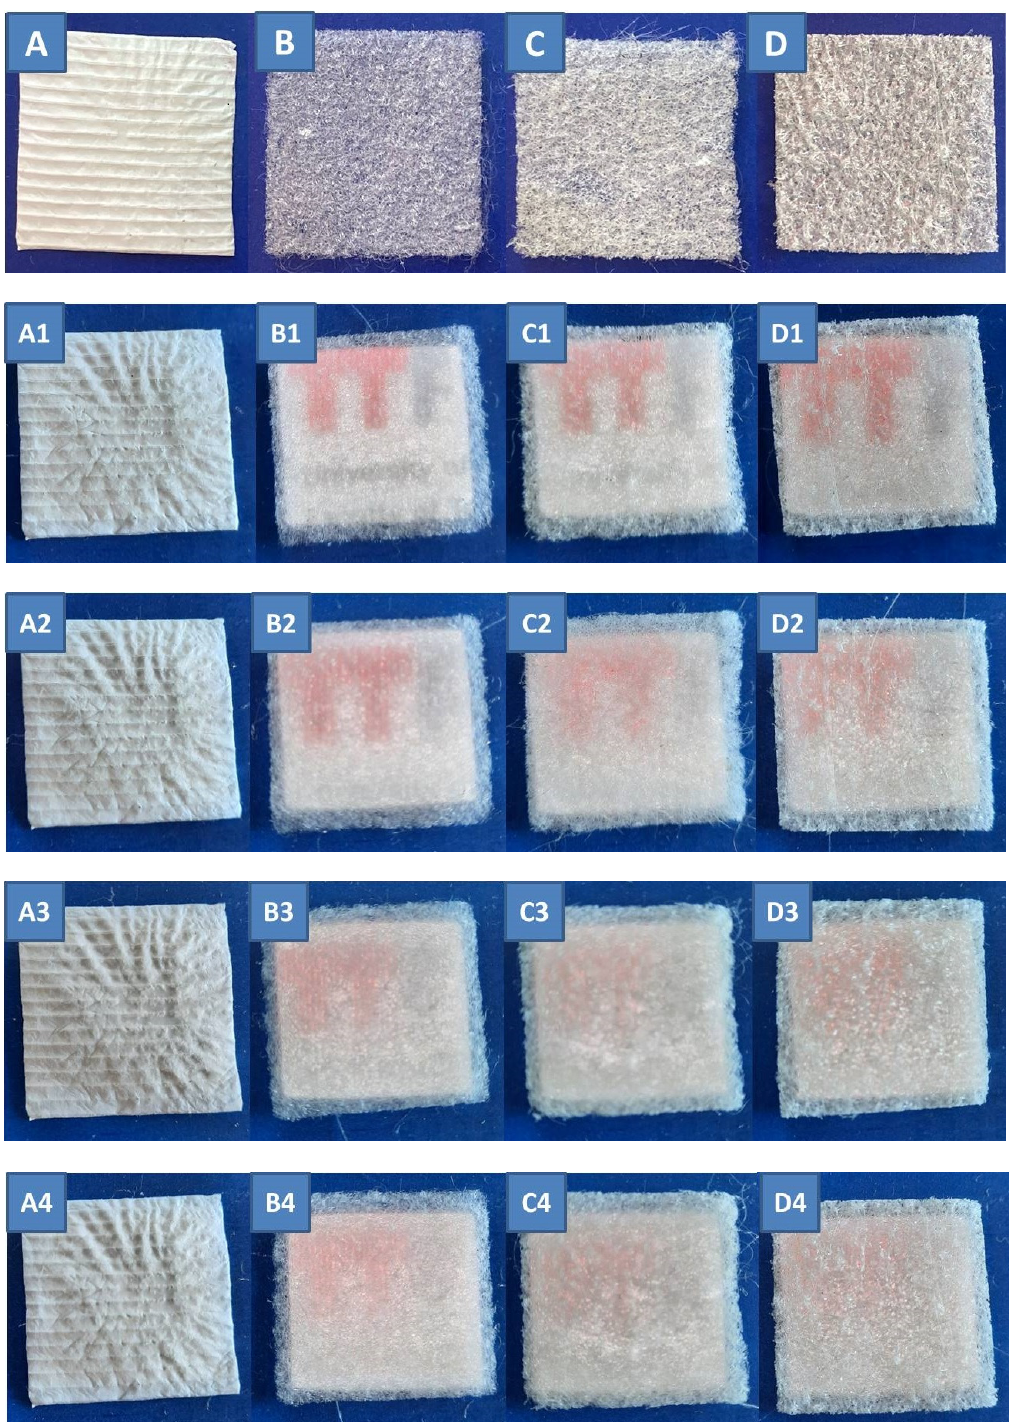
Figure 3. Photographs of: ( A ) PCL electrospun solution and the electrospun melt, ( B ) PLA, ( C ) PLA/silk fibroin, and ( D ) PLA/gelatin scaffolds; sample dimensions 30 × 30 mm; samples on illu- minated letter/text background with a distance of ( A1 – D1 ) 0 cm; ( A2 – D2 ) 0.5 cm, ( A3 – D3 ) 0.7 cm